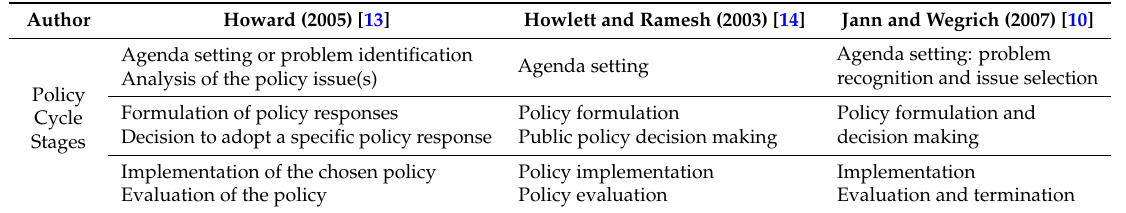
Table 1. Selected overview of policy cycle